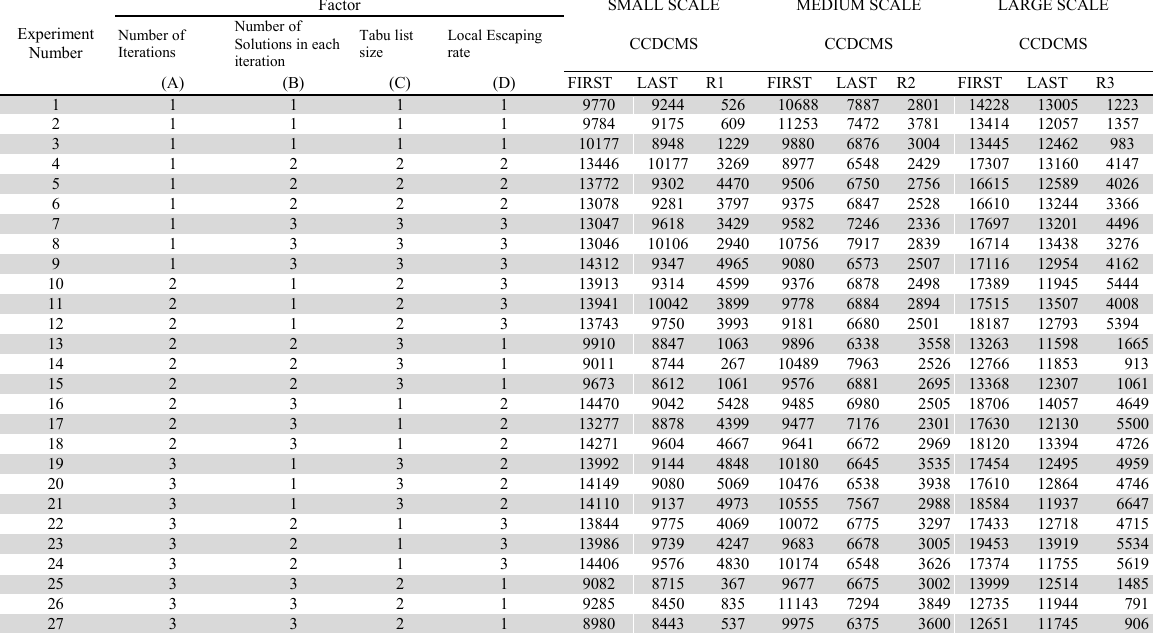
Results of implementing the L27(3^4) experiments for the proposed hybrid TS and SA Factor SMALL SCALE MEDIUM SCALE Number of Experiment Number of Tabu list Local Escaping Solutions in each Number Iterations size rate iteration